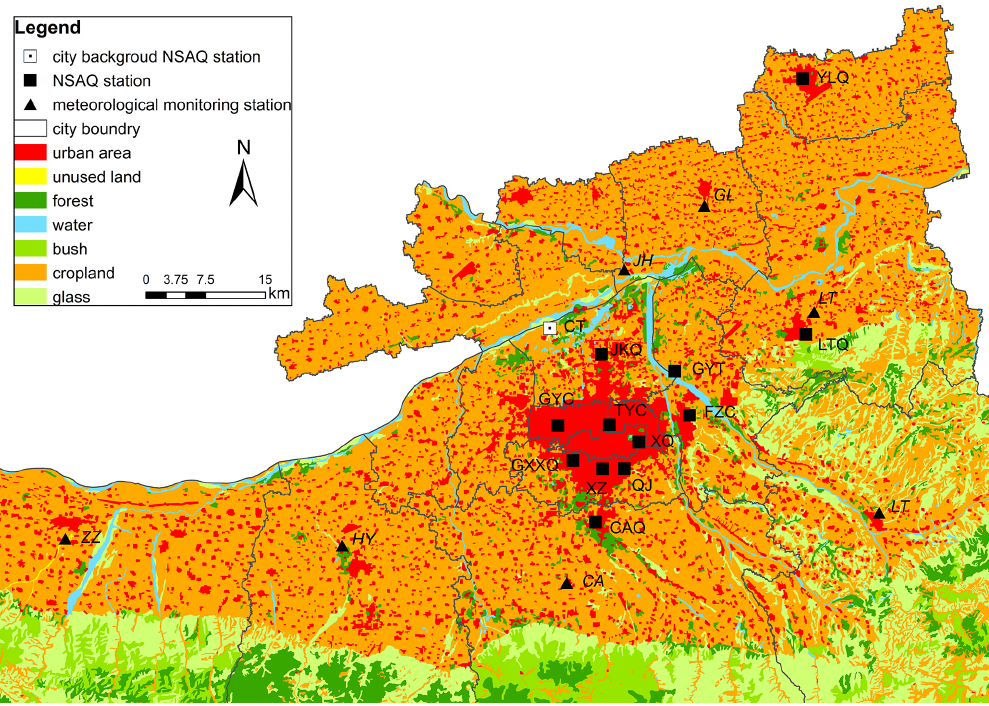
Figure 2. Map of the meteorological and air quality monitoring network in Xi’an. The triangles are the meteorological monitoring stations. The square with a dot in it is the city background station, and the black squares are the National Standard Air Quality (NSAQ) observation stations: Gaoyachang (GYC), Xingqing (XQ), Fangzhicheng (FZC), Xiaozhai (XZ), Tiyuchang (TYC), Gaoxinxiqu (GXXQ), Jingkaiqu (JKQ), Qujiang (QJ), Gaoyuntan (GYT), Changanqu (CAQ), Yanliangqu (YLQ), Lintongqu (LTQ), and Caotan (CT).